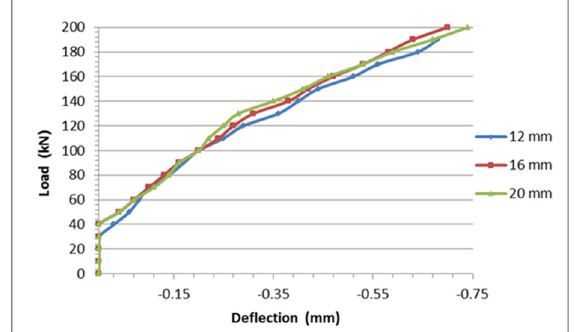
Fig. 11. Effect of Dowel Bar Diameter on Load- Deflection (Loaded Slab).